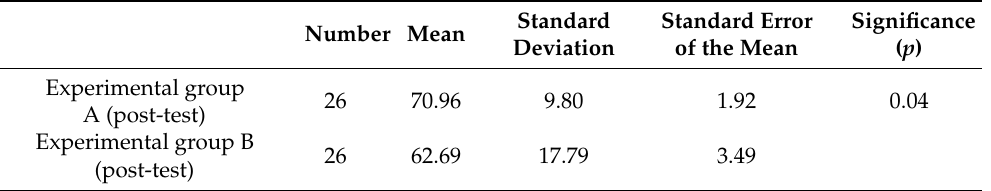
Table 9. Post-test t -test analyses of Experimental groups A and B.